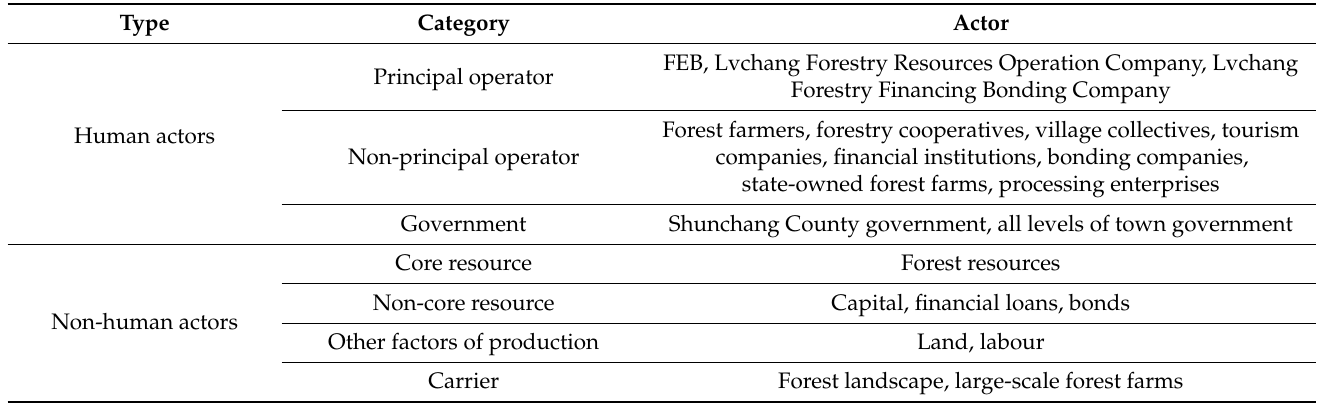
Table 1. Composition of the FEB actor